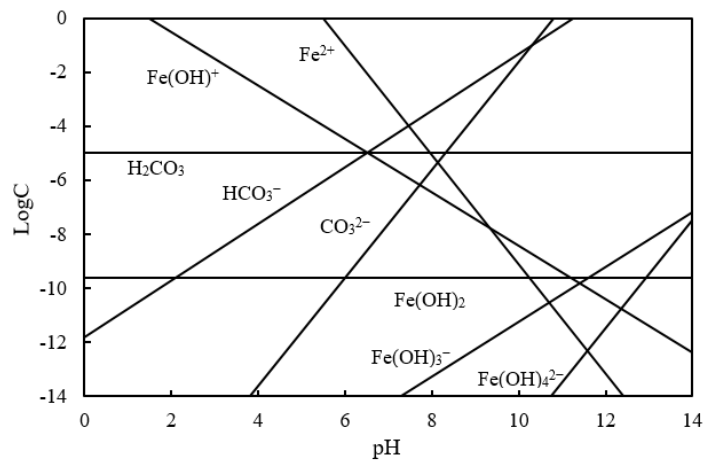
Figure 12. Species distribution diagram of siderite in aqueous solution at 25 °C (after [5]). It is possible to separately remove siderite and quartz from iron oxides using anionic collectors.